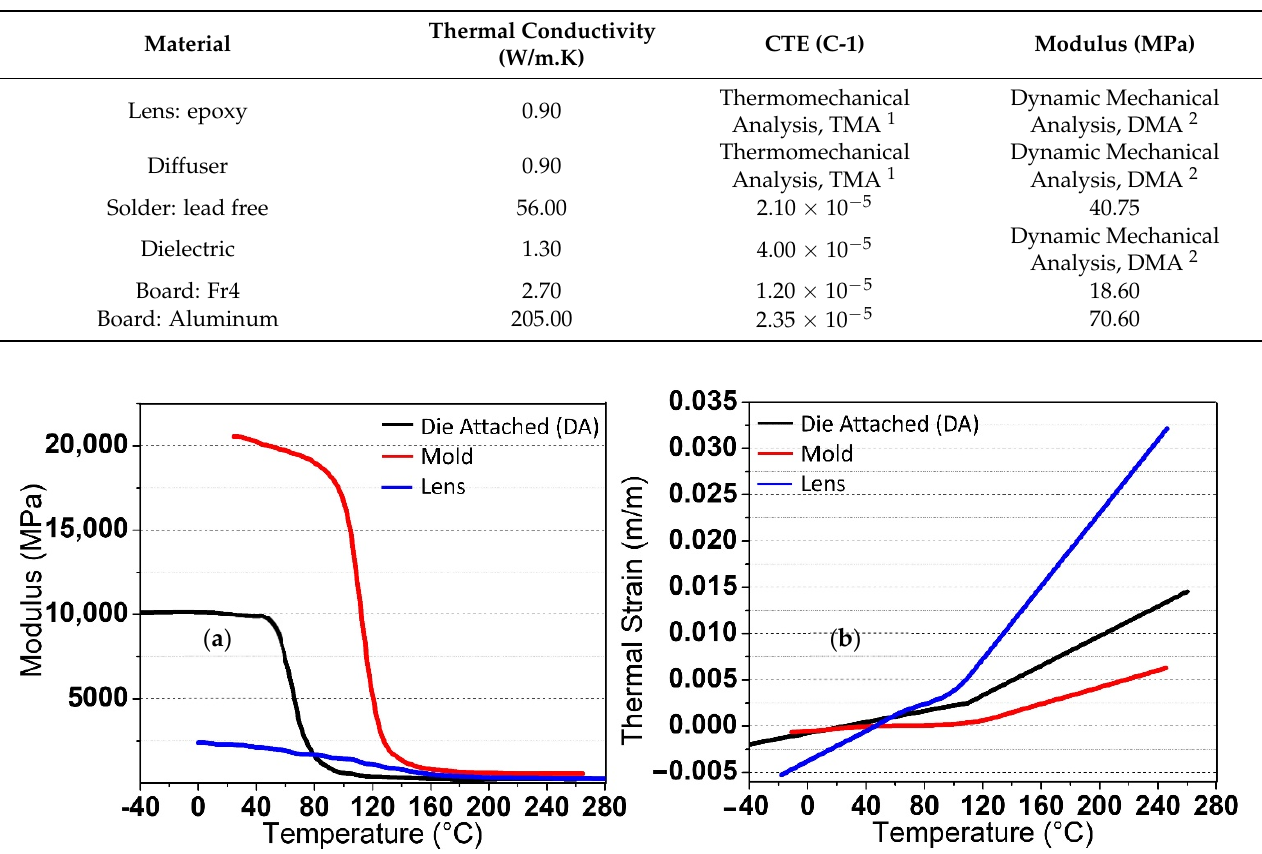
Figure 6. Material characteristics for the DA, mold, and lens using ( a ) Dynamic Mechanical Analysis (DMA) and ( b ) Thermomechanical Analysis (TMA).